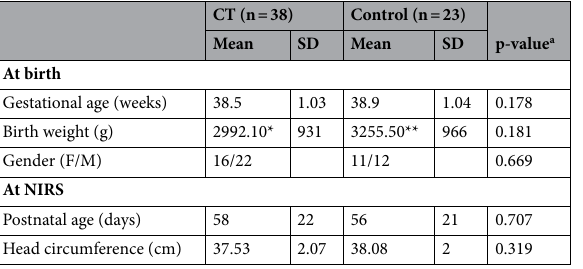
Table 2. Demographic characteristics of the children enrolled in this study. CT congenital toxoplasmosis; SD standard deviation. *10 subjects without information. **4 subjects without information. a Student t test (p <